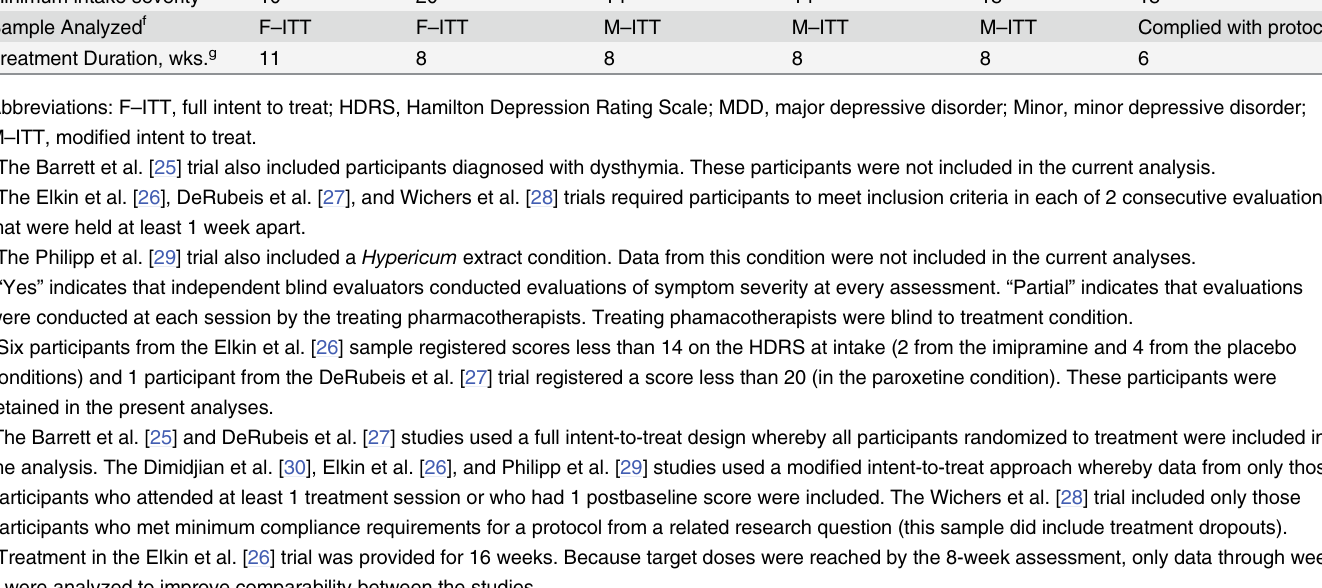
controls for the initial severity of depression for each participant in the second, third, fifth and sixth columns. Following [9], we examine two cutoffs for severe depression: an initial HDRS (cid:8) 25 and an initial HDRS (cid:8) 27. Regardless of the cutoff, the results are qualitatively un- changed across different specifications.